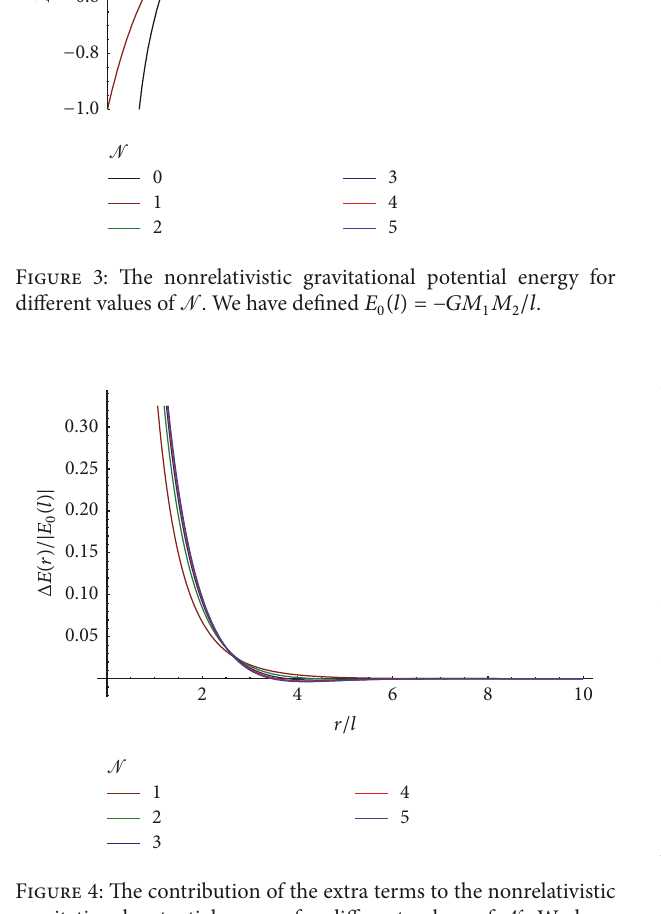
Figure 4: The contribution of the extra terms to the nonrelativistic gravitational potential energy for different values of N . We have defined 𝐸 0 (𝑙) = −𝐺𝑀 1 𝑀 2 /𝑙 .